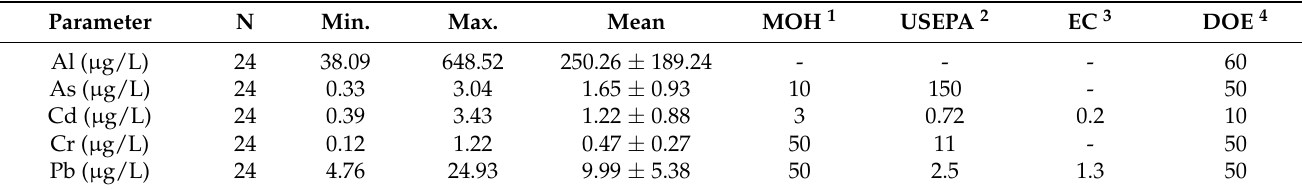
Table 1. Trace Metals in Langat River in comparison with several